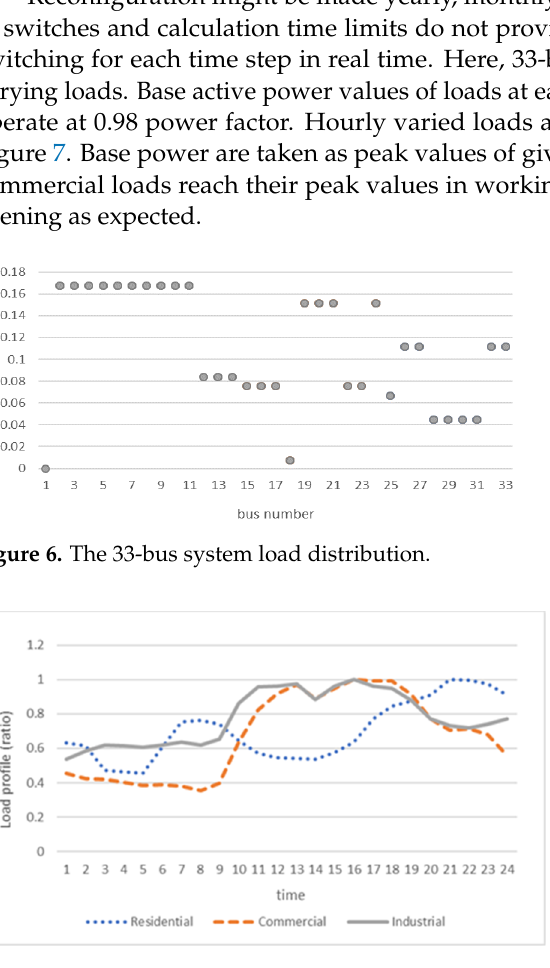
Figure 7. The 33-bus system normalized load profile. Table 4. Reconfiguration results of systems with time varying loads.